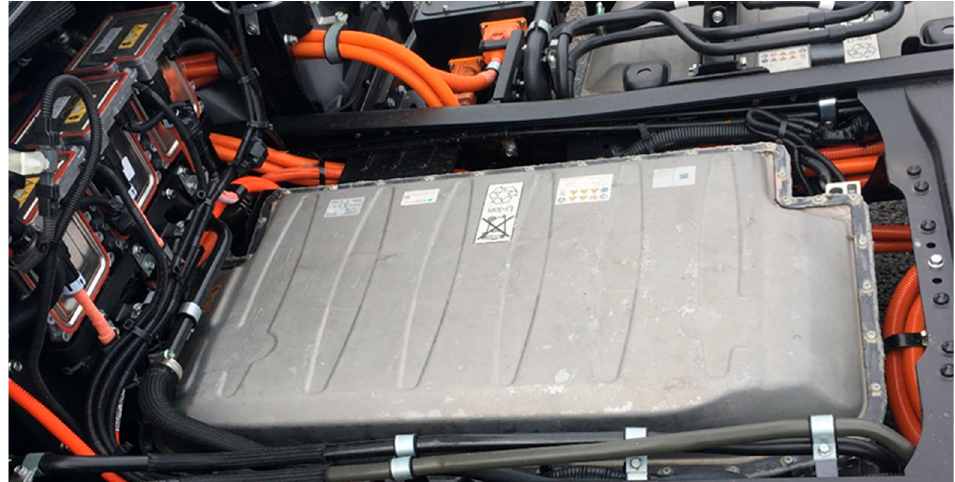
Figure 16. Chassis layout of a Mitsubishi Fuso E ‐ canter, highlighting a sealed battery pack and organised orange HV cabling. Photo taken by the author.